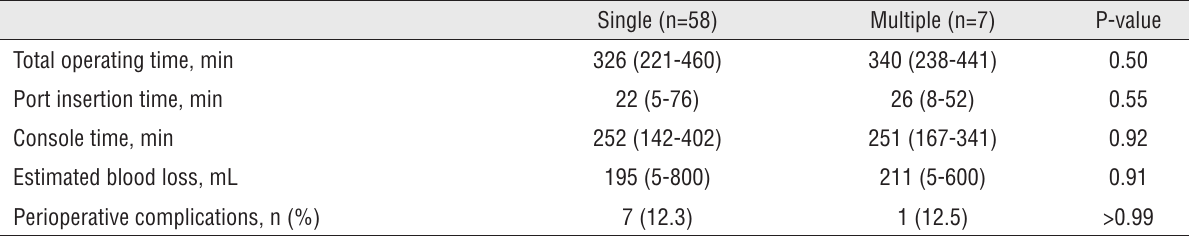
Table 5 - Comparison of patients with single or multiple prior abdominal